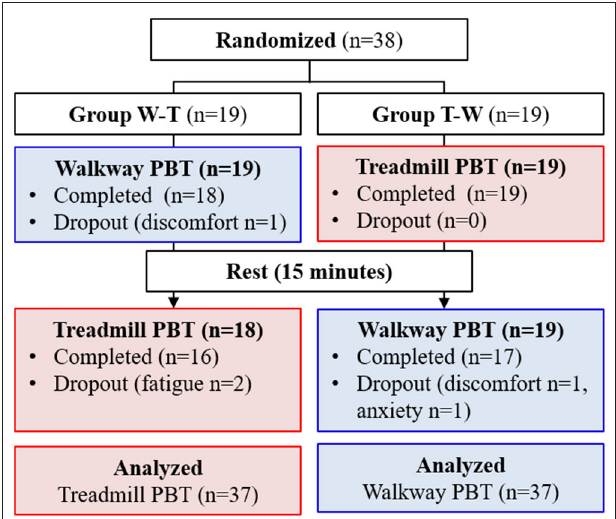
FIGURE 1 | Flow chart of the cross-over randomised controlled